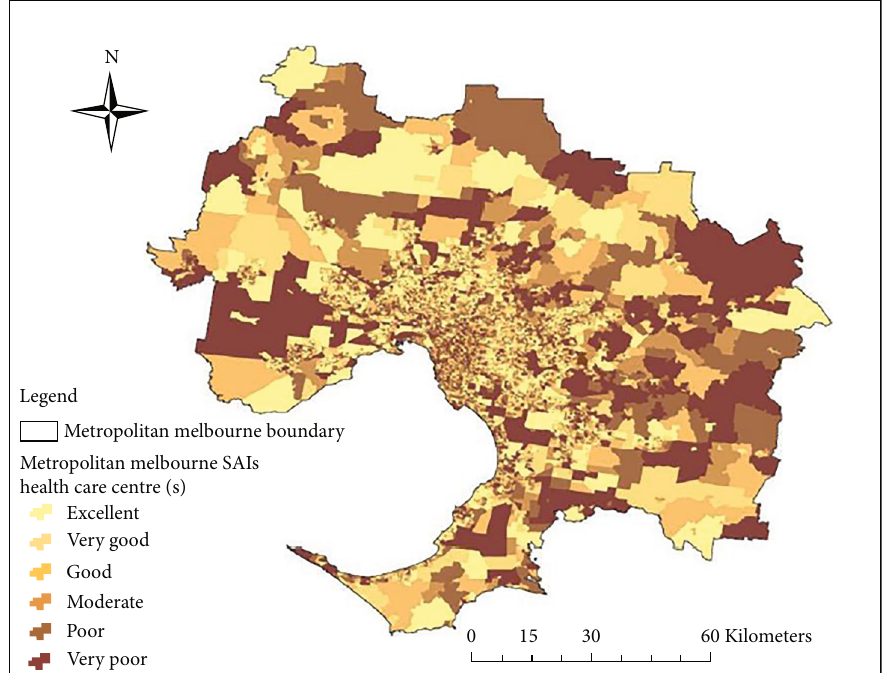
Figure 3: Older people public transport accessibility index for healthcare centre(s) (https://desktop.arcgis.com/en/arcmap/latest) [67].